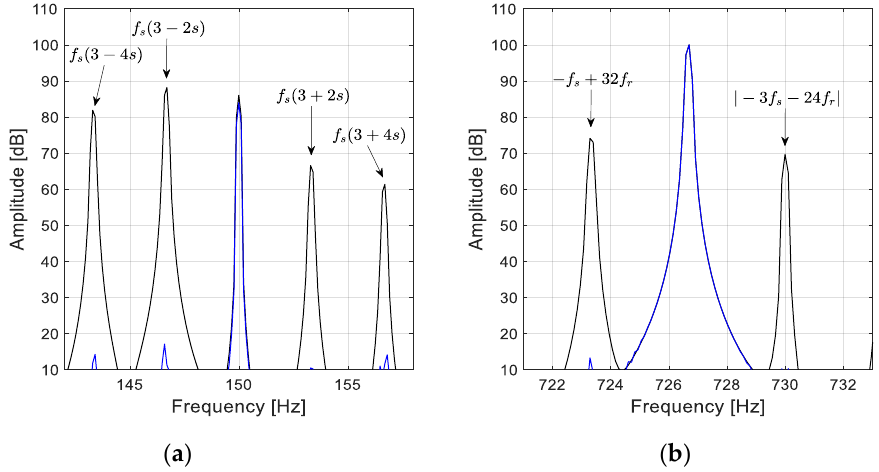
Figure 14. ZSC spectra comparison of motor with wye winding connection with neutral wire, healthy (blue color), with broken rotor cage (black color) around: ( a ) triple supply frequency, ( b ) base slot harmonic.